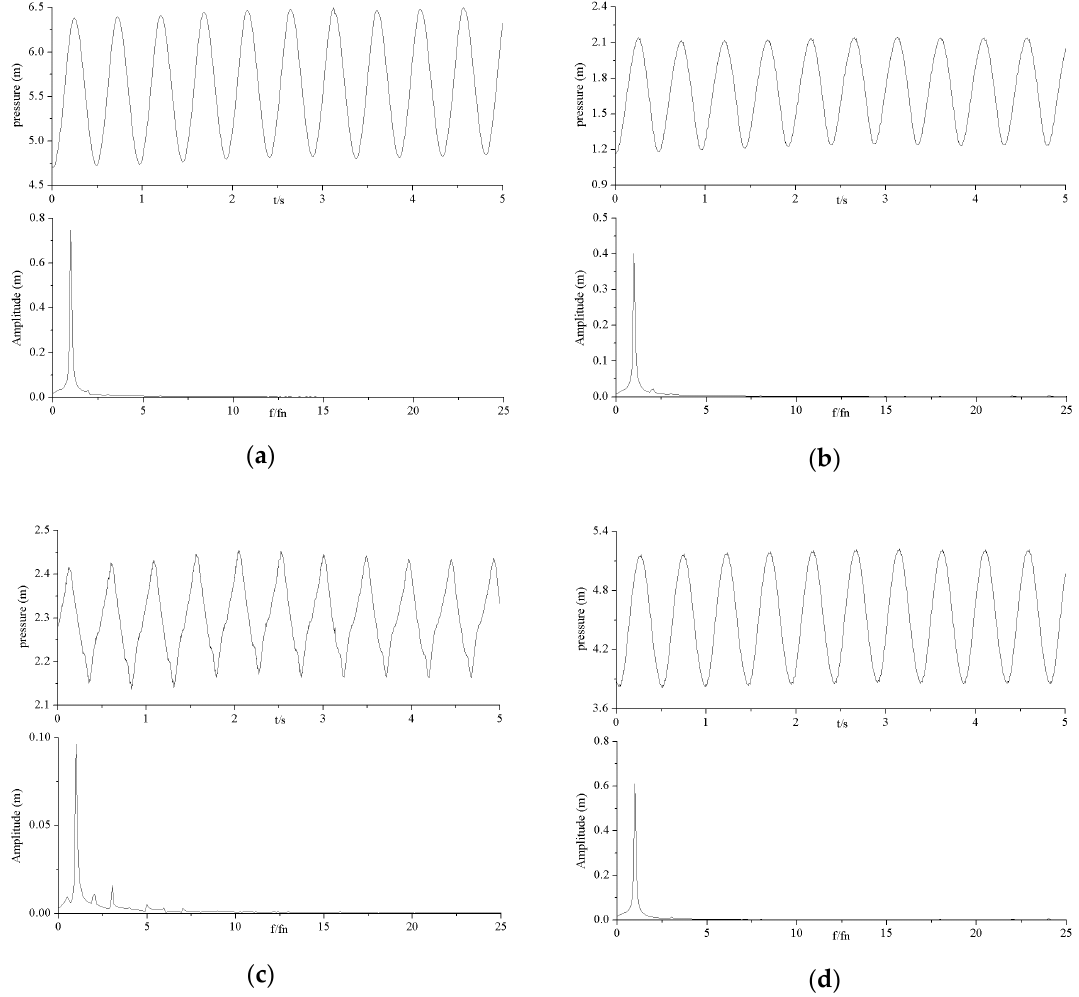
Figure 13. Time and frequency histories of pressure pulsations on the blade points for an optimal three-bladed runner: H = 3 m. ( a ) RP-ebb mode; ( b ) RP-flood mode; ( c ) RS-ebb mode; ( d ) RS-flood mode.